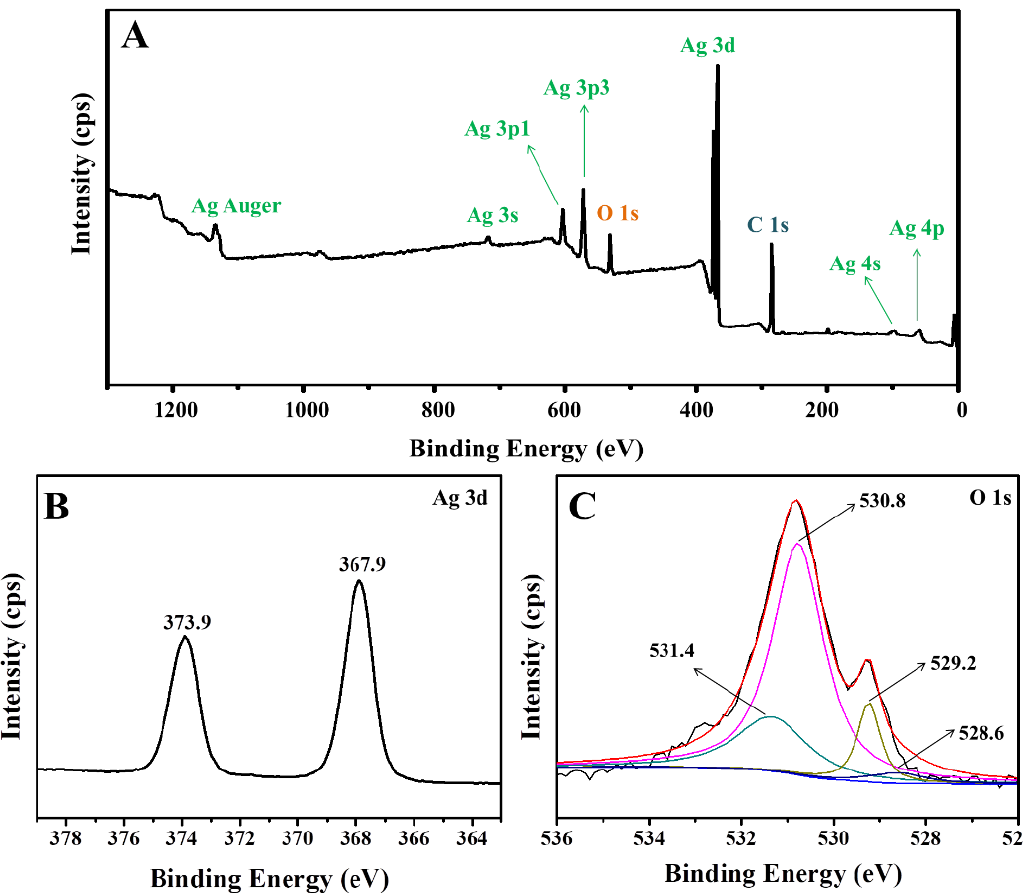
Figure 9. ( A ) XPS survey scan of HSANs obtained at 60 min UV irradiation time; high-resolution spectrum of ( B ) Ag 3d and ( C ) O 1s.